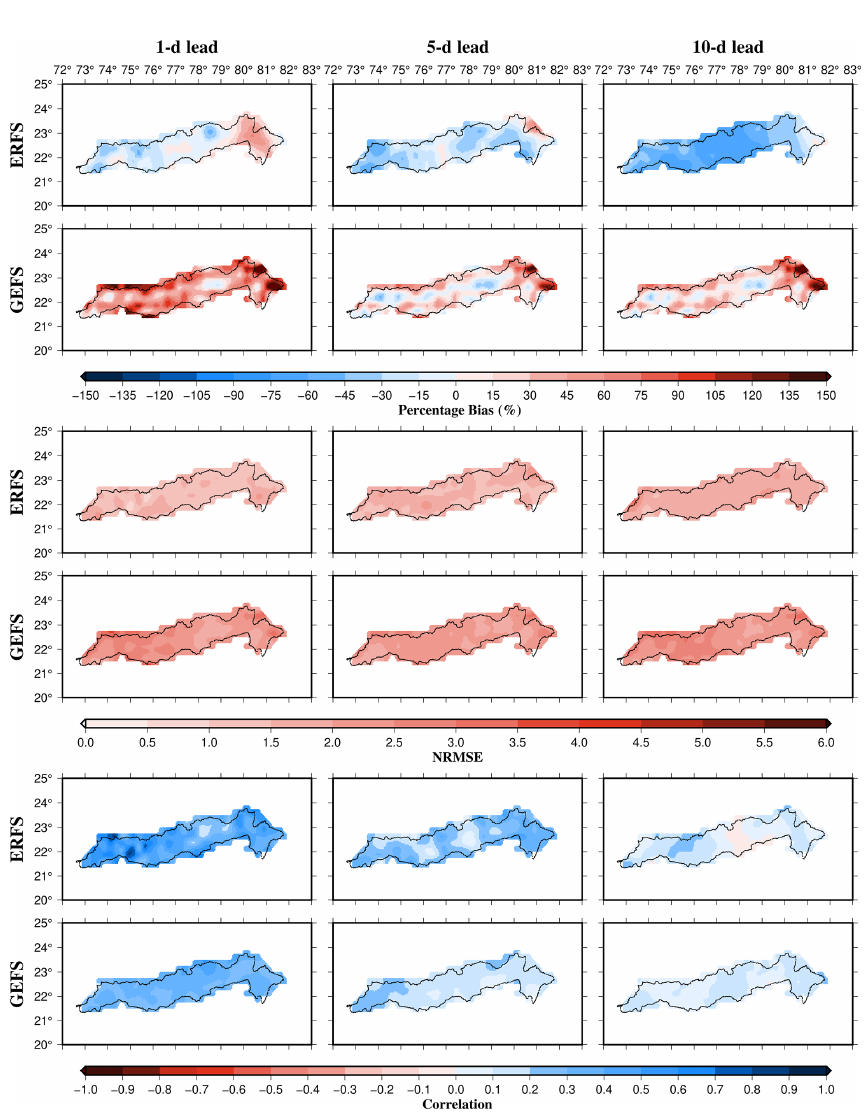
Figure 4. Comparison of the precipitation forecast skills from ERFS and GEFS for the summer monsoon period during 2019–2020. Forecast skills were evaluated using bias, NRMSE, and correlation for each ensemble member of ERFS and GEFS and the median skill is